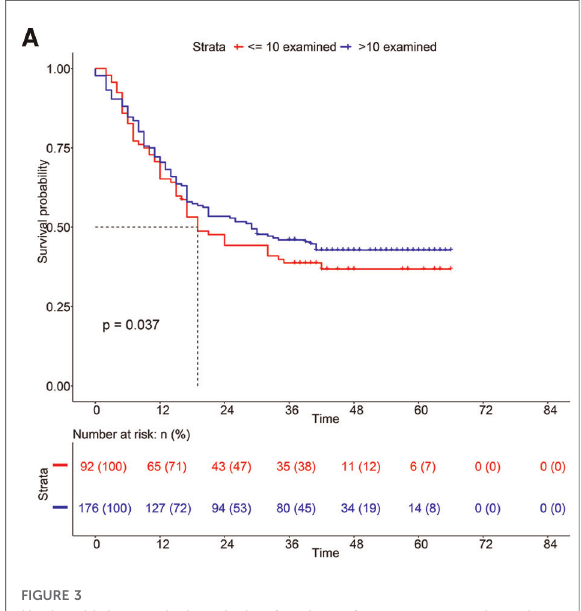
FIGURE 3 Kaplan-Meier survival analysis of patients from our center based on the number of